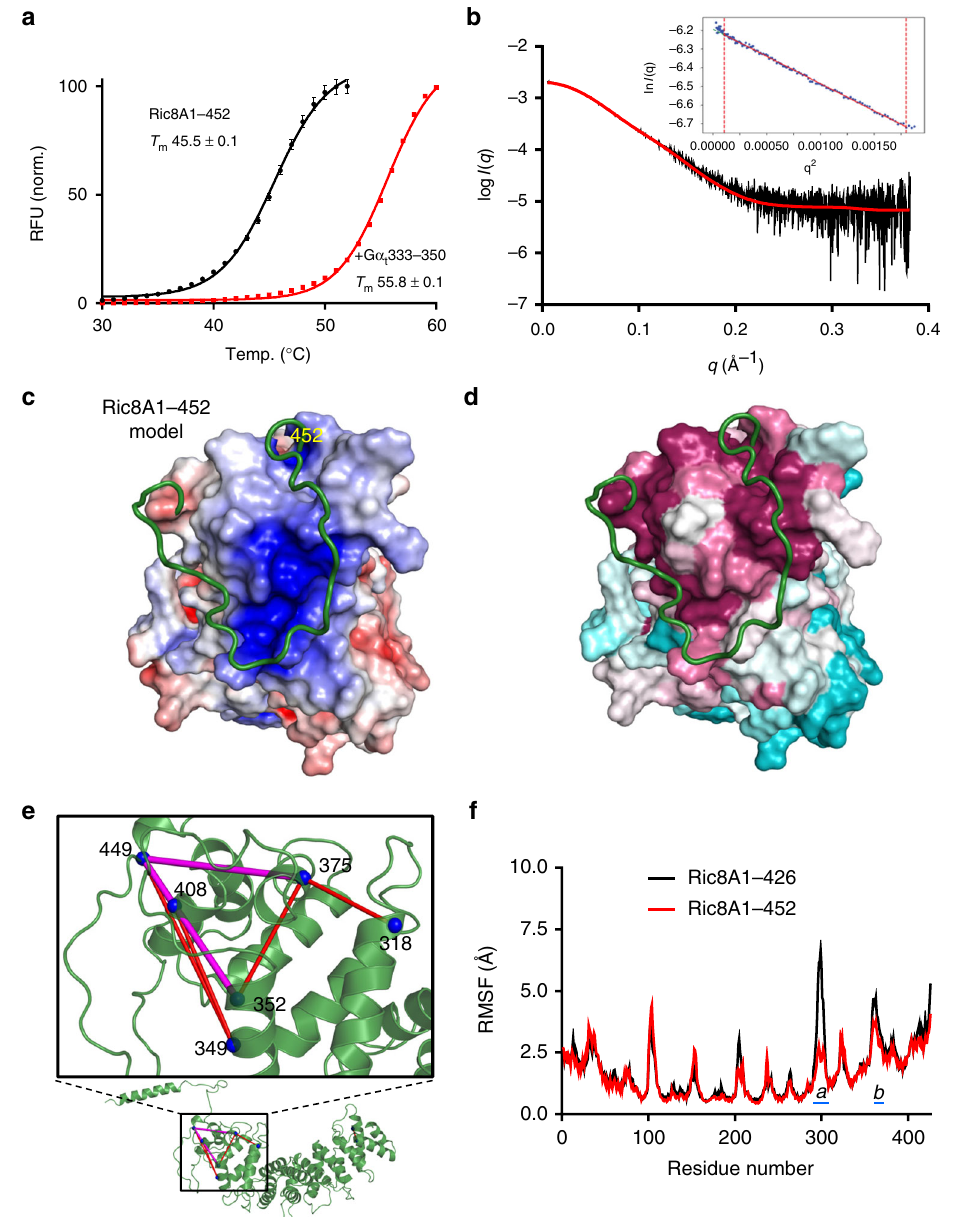
Fig. 5 Proximal portion of the Ric8A C-terminal tail binds and stabilizes the armadillo core domain. a Denaturation of 9.1 µ M Ric8A1 – 452, as determined by DSF, in the absence (black) or presence of 50 µ M G α t 333 – 350 (red). RFU – relative fl uorescence units. The T m values (°C) are shown as mean ± SD. b Experimental SAXS data for Ric8A1 – 452 (black). Theoretical SAXS pro fi le calculated for the Ric8A1 – 452 model fi ts the SAXS data with a χ 2 value of 1.82. The Guinier plot for the low q region ( q ∙ R g < 1.3) is shown in the inset. c , d . The best-scoring FloppyTail model of Ric8A1 – 452 from cluster I. The proximal C-terminal region Ric8A423 – 452, shown as a ribbon, the core domain Ric8A1 – 422 shown as electrostatic surface representation (units K b T / e c ) ( c ) or as a conservation surface (based on ConSurf analysis Ric8 homologs ( d ); the color scale represents conservation scores, 9 – magenta – conserved, 1 – cyan - variable). e . Close-up of the model of apo Ric8A1 – 492 showing the region with the highest concentration of intramolecular DSS-crosslinks. Eight of the total nine crosslinks (blue) were identi fi ed in the C-terminal half of Ric8A. Crosslink K352/K449 is obscured by crosslinks K352/K408 and K408/K449. All the crosslinks satisfy the distance threshold of 30 Å 74 . Crosslinks K352/K449 and K408/K449 used in FloppyTail modeling of Ric8A1 – 452 and crosslink K375/K449 used in model selection are colored in magenta; all other crosslinks are in red. f RMSF plots averaged from four MD simulations (Supplementary Fig. 18) for each Ric8A1 – 426 (black) and the model of Ric8A1 – 452 (red). The fl exible regions a and b of Ric8A signi fi cantly stabilized by the proximal part of its C-terminal tail are indicated with a blue line. The peak average RMSF values (Å) for a (6.7 ± 1.4 vs. 2.1 ± 0.4 (mean ± SE, n = 4), unpaired t- test * P = 0.02, residue 299) and b (4.7 ± 0.2 vs. 3.7 ± 0.1, unpaired t- test ** P = 0.004, residue 363) are statistically different. Source data are provided as a Source Data fi